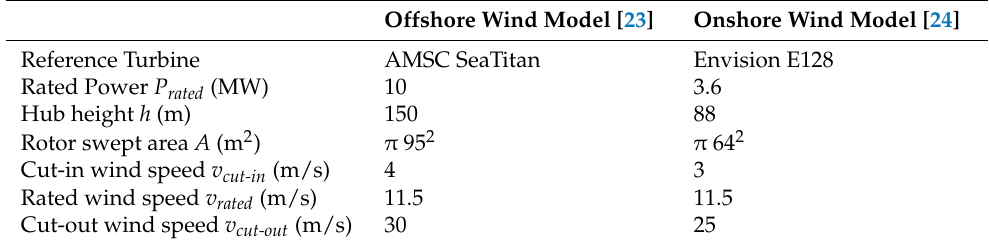
Table 1. Technology input data used for offshore and onshore wind turbines in this